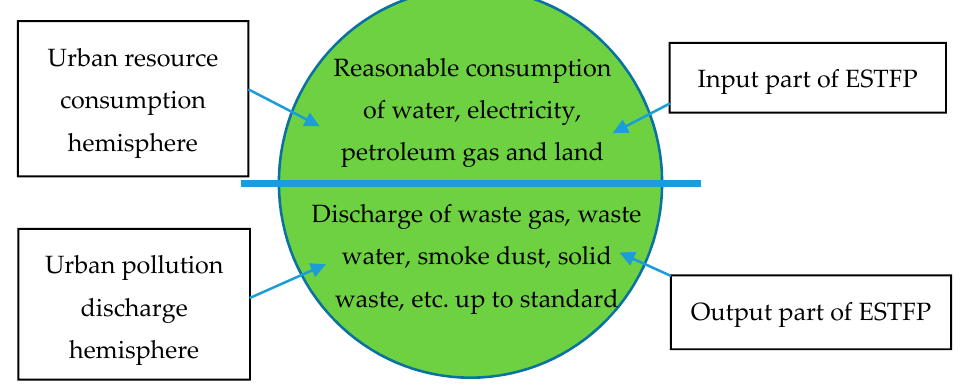
Figure 3. Urban Ecological Sustainable Hemisphere.